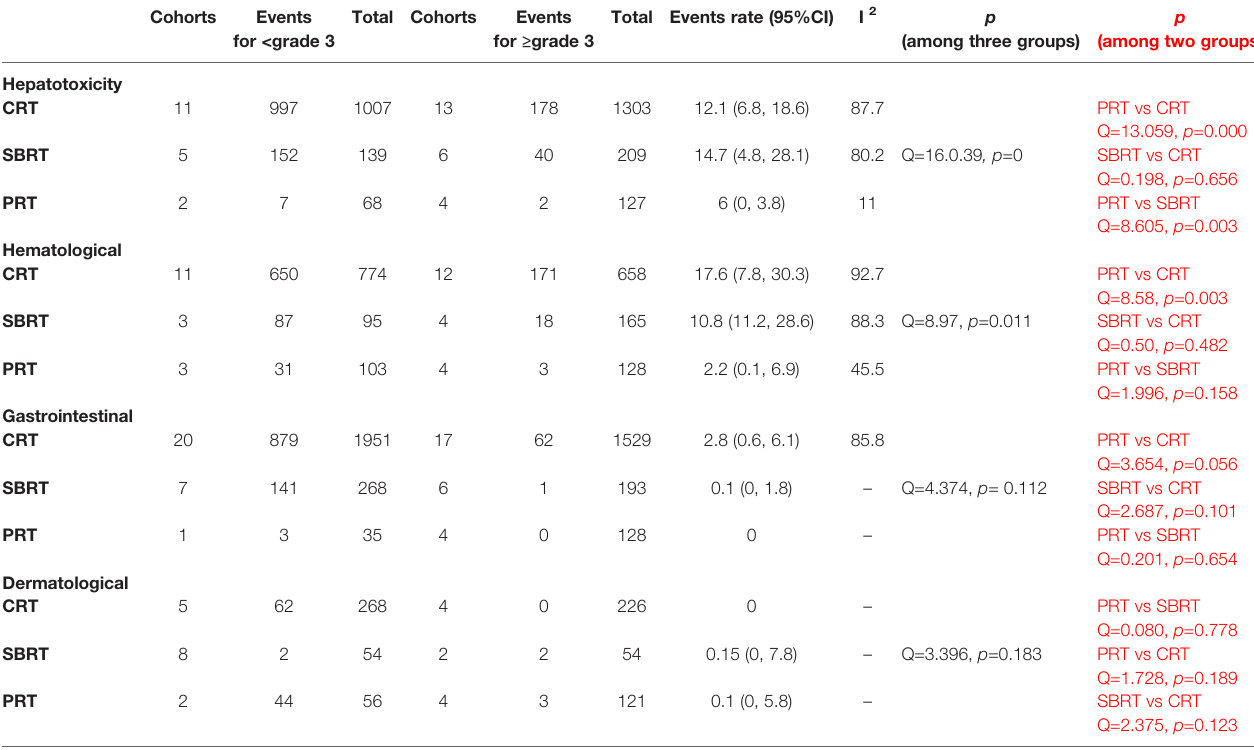
TABLE 5 | Comparison of toxic effect events for